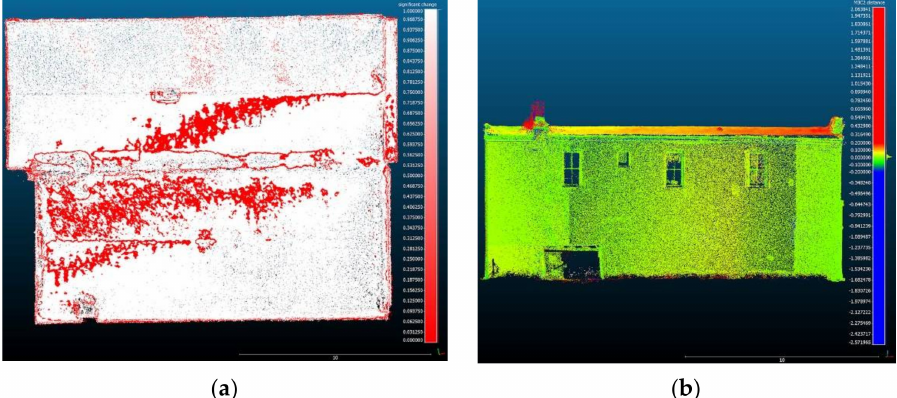
Figure 15. ( a ) Dechambeau Hotel and IOOF Hall roof significant change. Point size increased to “2” to decrease transparency in the structure. No other features have been modified; ( b ) Dechambeau Hotel and IOOF Hall south wall. M3C2 distance displayed in centimeters. ( a , b ) By A. Guillem and C.